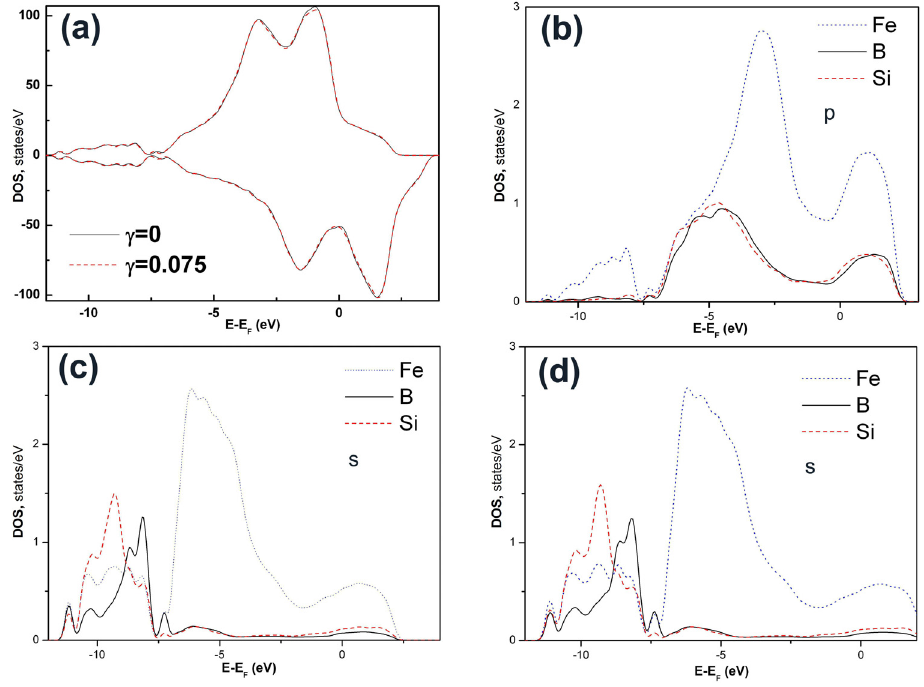
Figure 5. ( a ) Total density of states (DOS) of Fe-Si-B un-deformed and deformed (shear strain 0.075) glassy alloy at ambient pressure. The DOS is positive for majority-spin states and negative for minority-spin states. ( b , c ) Local DOS of p electrons and s electrons of the atoms in the un-deformed Fe-Si-B glassy alloy, respectively. ( d ) Local DOS of s electrons of atoms in the deformed (shear strain 0.075) Fe-Si-B glassy